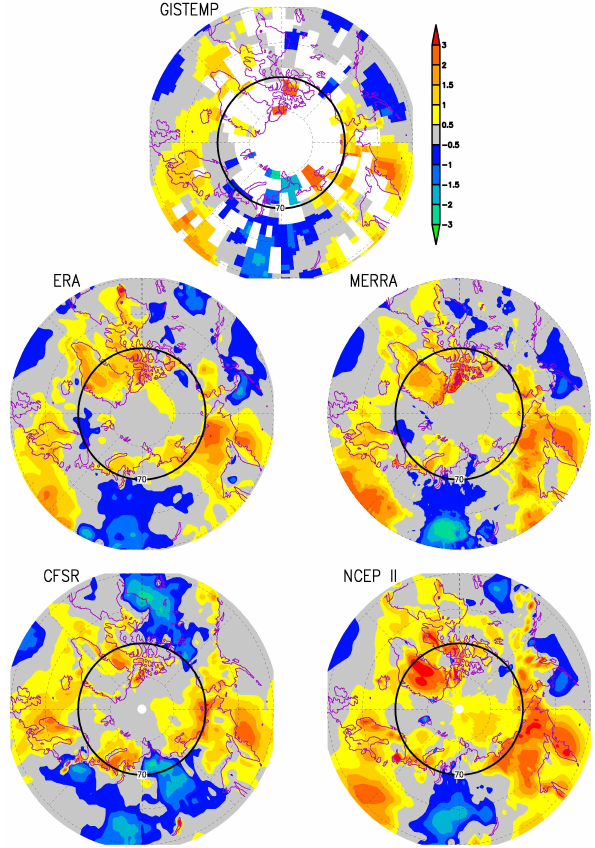
Fig. 11. June–August average T s trend from 1998 to 2011 in units of change (in K) over the 14yr for GISTEMP and for the four reanal- yses. In the case of CFSR, the trend is from 1998 to 2009 in units of change over the 12yr. White areas in the GISTEMP plot indicate missing data or insufficient data for the trend analysis. Note that T s refers to surface air temperature (SAT) for the reanalyses, and to a combination of SAT over land and SST over ocean for GISTEMP. The 70 ◦ N circle is thickened in each